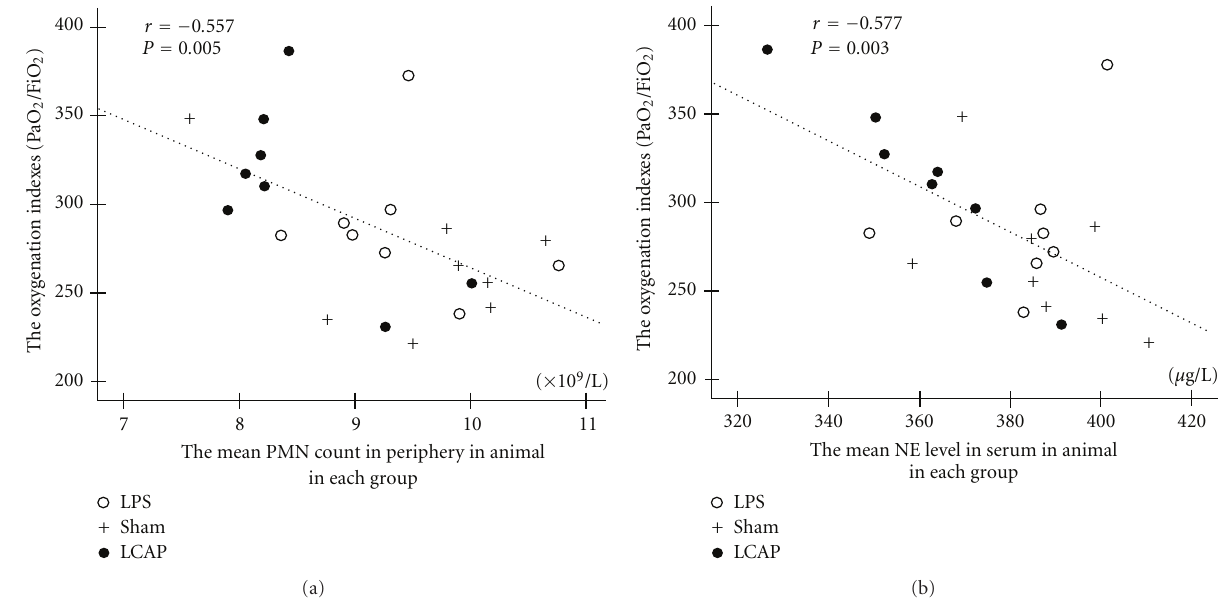
Figure 5: The correlation between oxygenation indices and the average levels of the PMN count in periphery and NE in serum. We calculated the mean levels of PMN in the peripheral blood at indicated time period and showed the correlation between the mean levels of PMN in the periphery and the oxygenation indices (PaO 2 /FiO 2 ) at 36 h ( r = − 0 . 557, P = 0 . 005) (a). The correlation between the mean levels of NE in serum and the oxygenation indices at 36 h were examined ( r = − 0 . 575, P = 0 . 003)